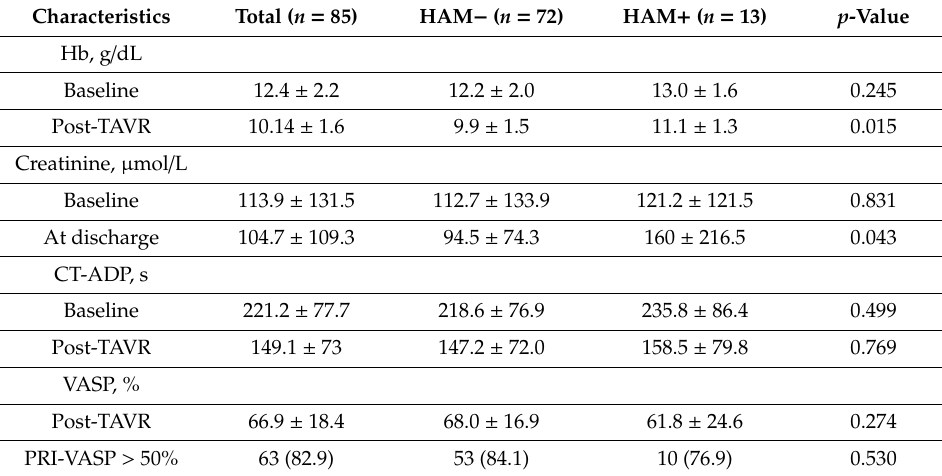
Table 2. Biological characteristics.